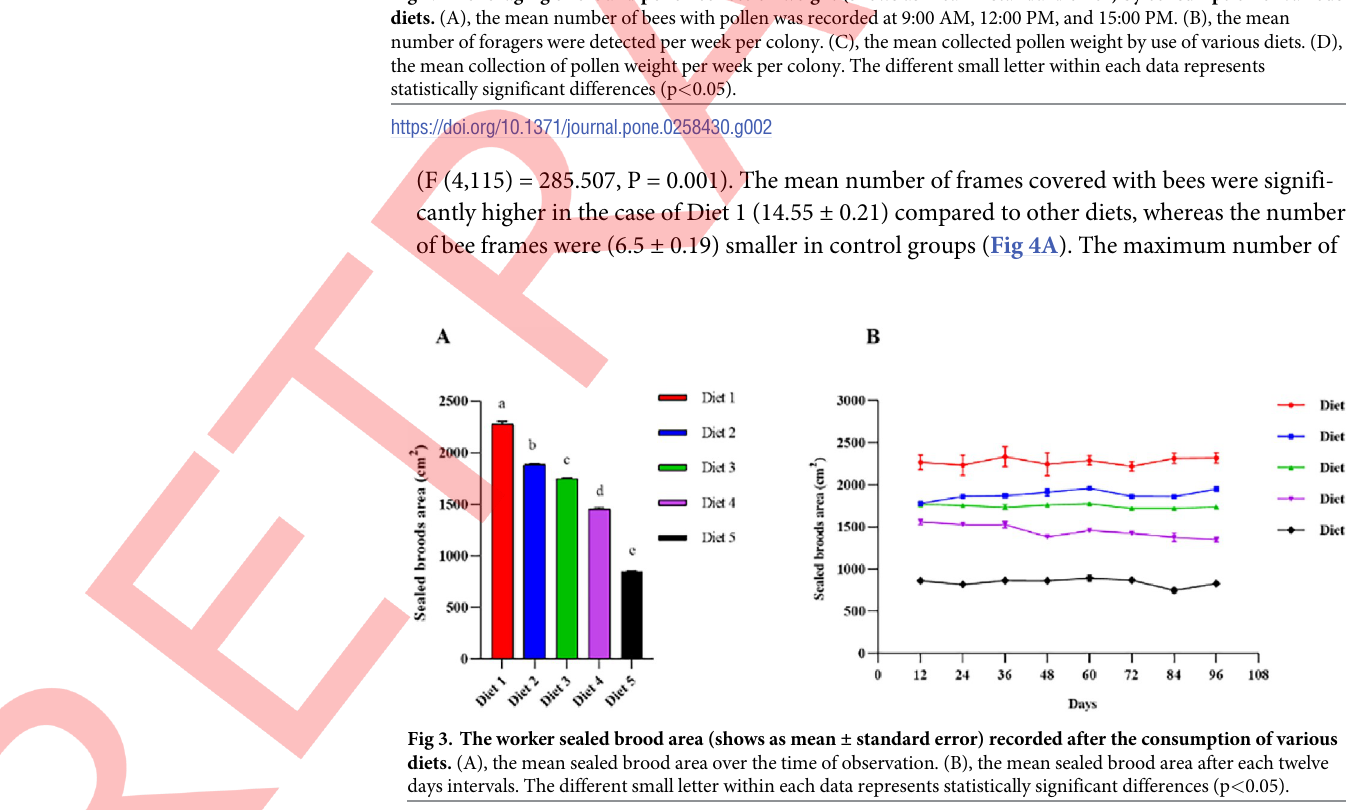
Fig 3. The worker sealed brood area (shows as mean ± standard error) recorded after the consumption of various diets. (A), the mean sealed brood area over the time of observation. (B), the mean sealed brood area after each twelve days intervals. The different small letter within each data represents statistically significant differences (p <